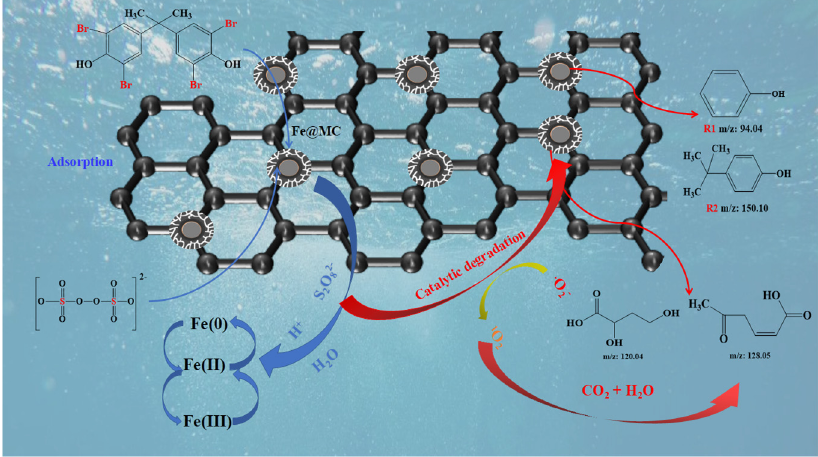
Figure 7. Degradation mechanism of TBBPA in the Fe@MC/PS system.